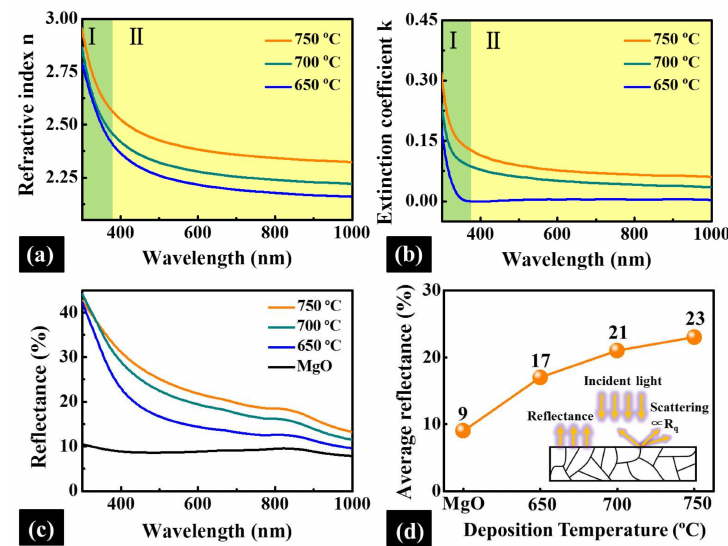
Figure 5. The refractive index ( a ); and extinction coefficient ( b ) of PLZT thin films deposited at various temperatures over a wavelength between 300 nm and 1000 nm. ( c ) The reflectance spectra of the pristine MgO substrate and PLZT thin films at different deposition temperatures in the visible and near-infrared regions. ( d ) Plots of the corresponding average reflectance of MgO and PLZT thin films. The inset of ( d ) is the scheme of the light attenuation of PLZT thin films.